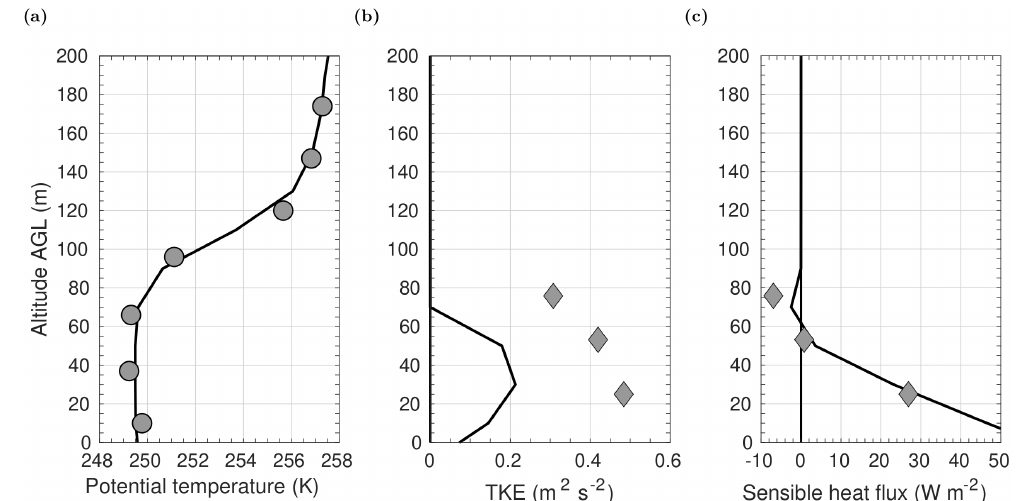
Figure 16. Three different observed and modelled quantities against altitude above ground level (AGL) for the area around the lead observed on 2 August 2013. ( a ) potential temperature measured with the radiosonde from RV at 11:03 UTC (grey circles, [42] and the corresponding inflow profile for the idealized simulation with the non-eddy resolving model METRAS (black lines). ( b , c ) observed values (grey diamonds) and lead-averaged simulation results (black lines) of the turbulent kinetic energy (TKE) and the sensible heat flux. The observed values were calculated from the M 2 AV flight legs at the three altitudes of 25, 50 and 75m. The time of the flights was 13:04 to 13:48 UTC.